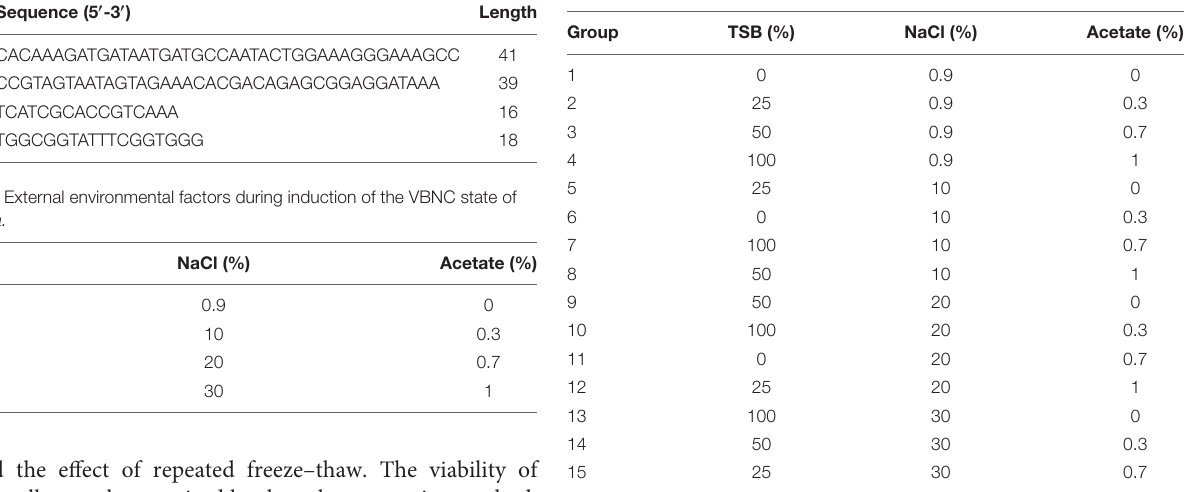
TABLE 4 | The experimental methods of orthogonal array design of VBNC induction of